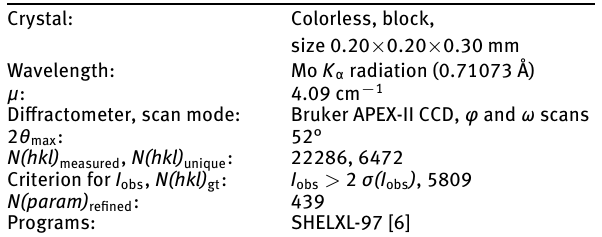
Table 1: Data collection and handling.